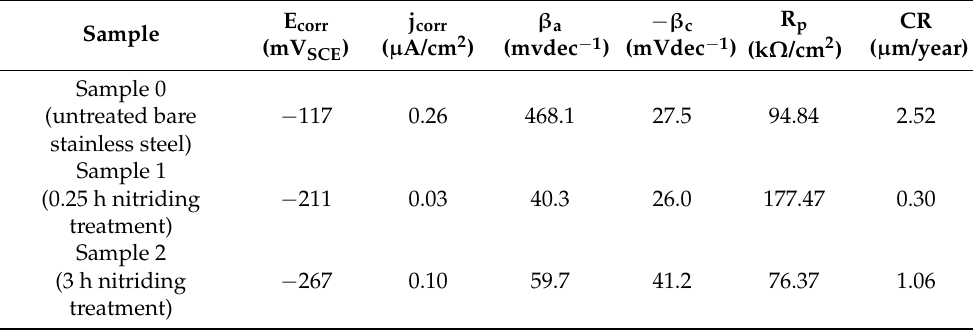
Table 2. Corrosion parameters for bare and nitriding stainless steel in 0.1 M NaCl determined by Tafel extrapolation method.